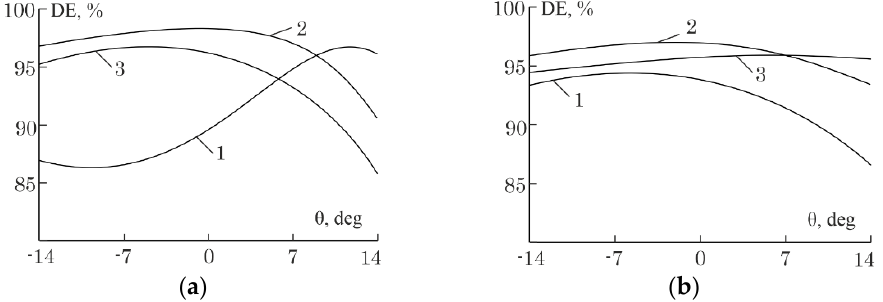
Figure 5. The calculated DE dependence on the angle of incidence for microstructure: ( a ) Curved lines 1, 2, and 3 at λ = 3.4, 4.3, and 5.2 μ m, respectively; ( b ) Curved lines 1, 2, and 3 at λ = 7.5, 9.45, and 11.4 μ m, respectively.